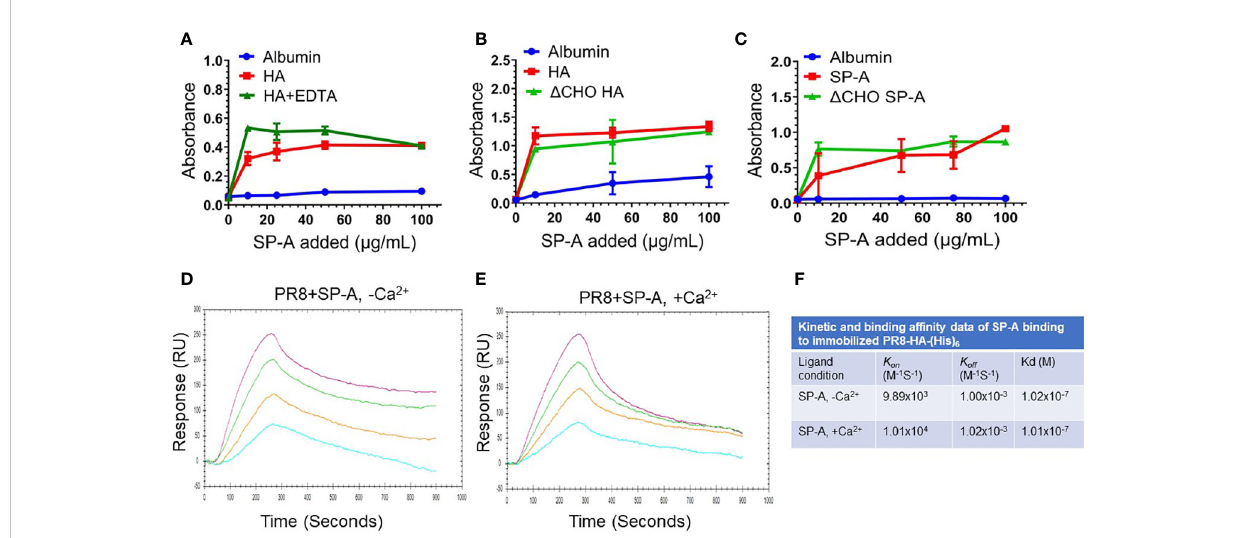
FIGURE 2 SP-A binds HA in a calcium and glycosylation independent manner. SP-A binding to HA was carried out in static solid phase assays (A-C) and under fl ow using surface plasmon resonance (SPR) (D-F) . For static assays, recombinant PR8 HA (1 m g/well) was adsorbed onto 96-well Immobilon-2 plates in 0.05 M bicarbonate buffer (pH 9.6) overnight at 4°C. Coated plates were incubated with albumin control or SP-A at room temperature for 1 hour. Plates were washed in binding buffer and incubated with a polyclonal SP-A antibody. Bound SP-A was visualized colorimetrically using